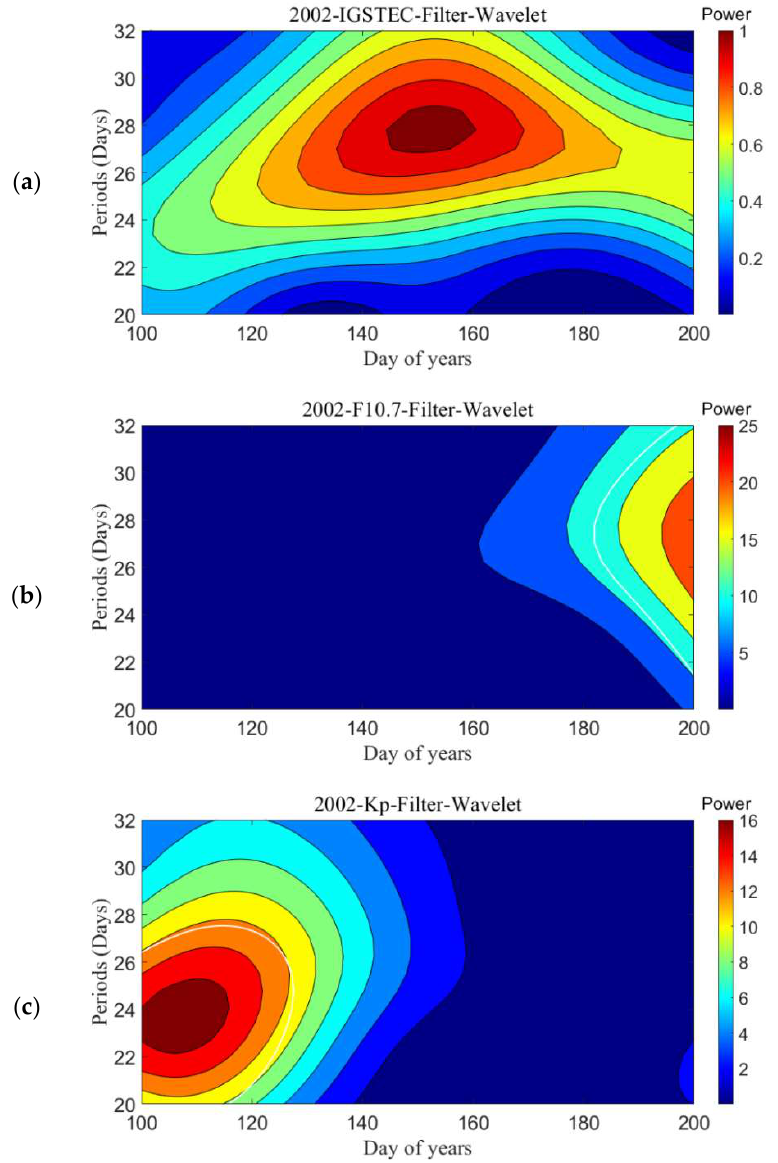
Figure 9. ( a – c ) Wavelet analysis of IGS-TEC, F10.7, and Kp oscillation during Days 100–200, 2002. Having ruled out the solar and geomagnetic activity as the cause of the event, internal atmospheric dynamical process emerged as a possible cause. Using the neutral winds model data from SD-WACCM-X built by NCAR, the zonal winds at the latitude of the Wuhan area (31°N) were studied. A 90 km height was selected for the model data, to rep- resent the variation in the zonal wind field in the mesosphere lower thermosphere (MLT)